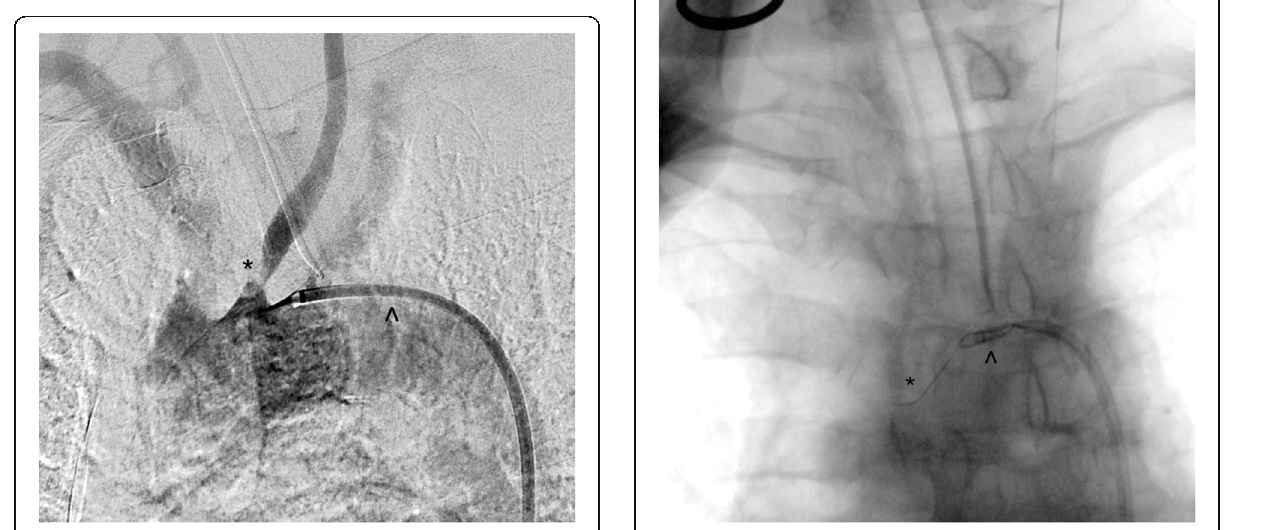
Fig. 1 Catheter angiogram demonstrating the stenosed left common carotid artery origin (*). The Neuron Max catheter (^) tip is situated near the ostium of the left common carotid artery